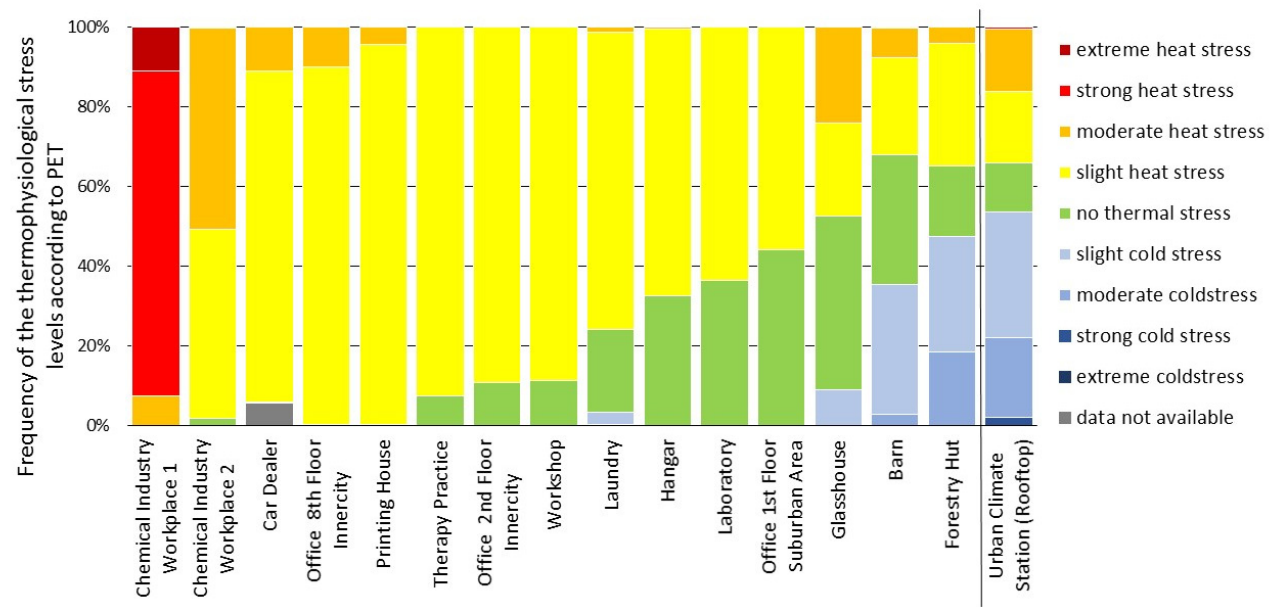
Figure 9. Distribution of thermal comfort according to physiologically equivalent temperature (PET) measured by MoBiMets at different workplaces in Freiburg and at the urban climate station during a clear-sky week between 2 September and 9 September 2021.